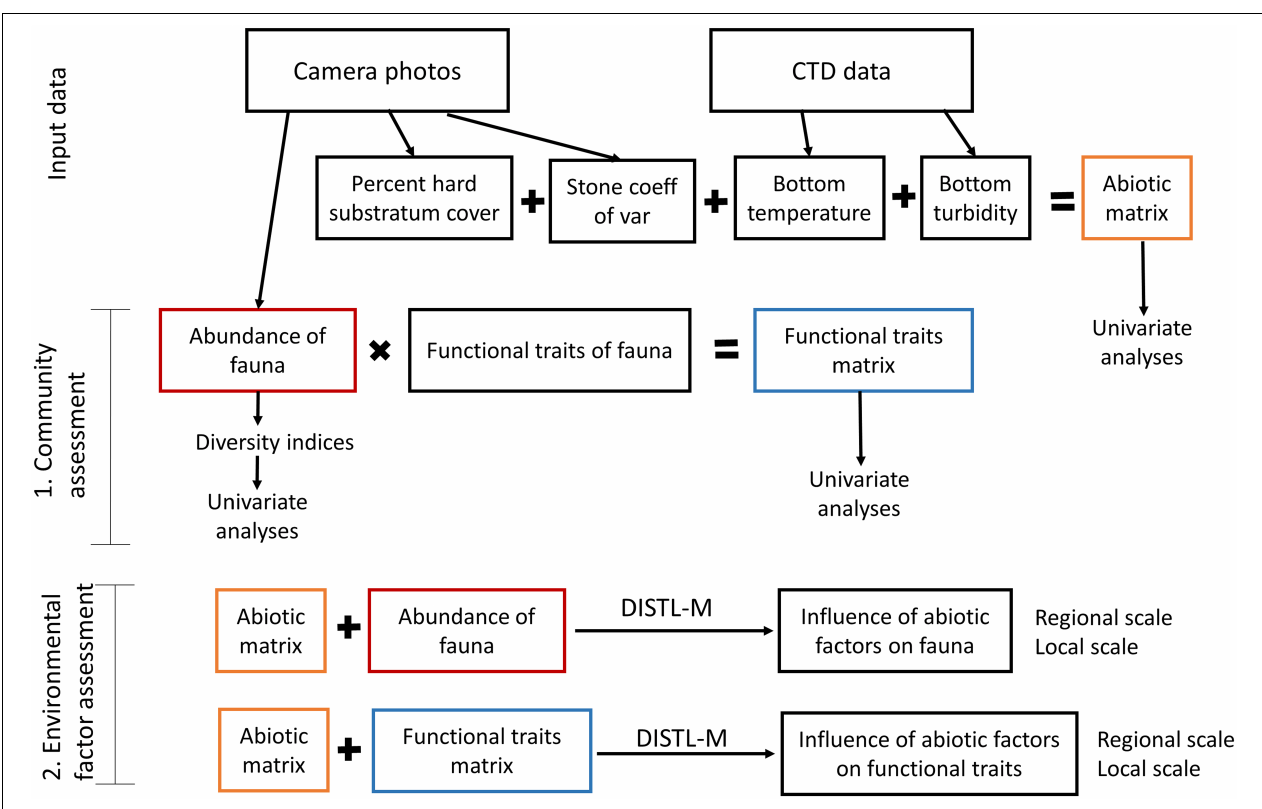
FIGURE 2 | Conceptual outline of statistical analyses conducted in this study.